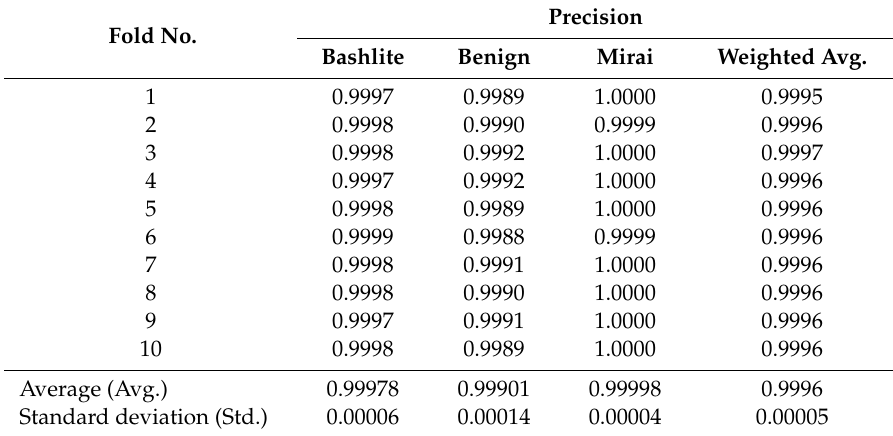
Table 8. Precision results of the 10-fold cross-validation for Mirai, Bashlite, and benign classifications using the selected feature numbers.